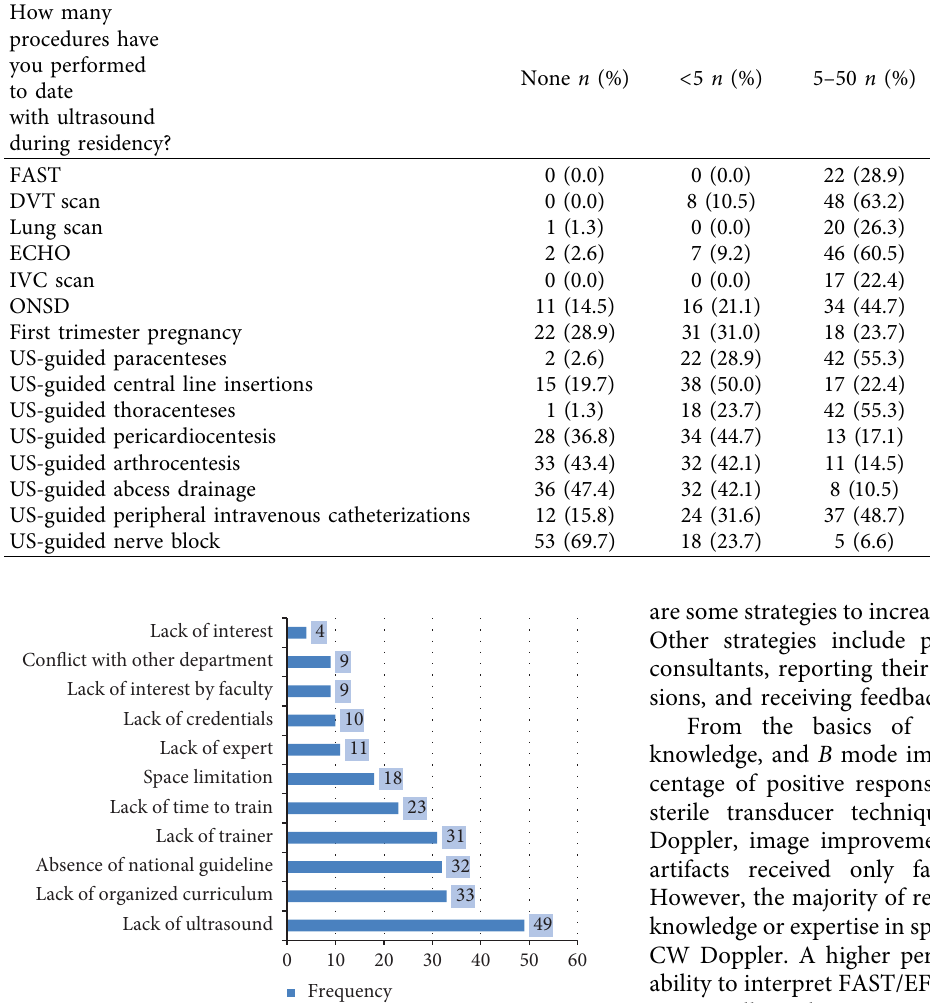
Figure 1: Barriers for POCUS utilization by senior emergency medicine and critical care residents in SPHMMC and AAU/TASH, Addis Ababa, Ethiopia, June 1–August 30, 2022 ( N �